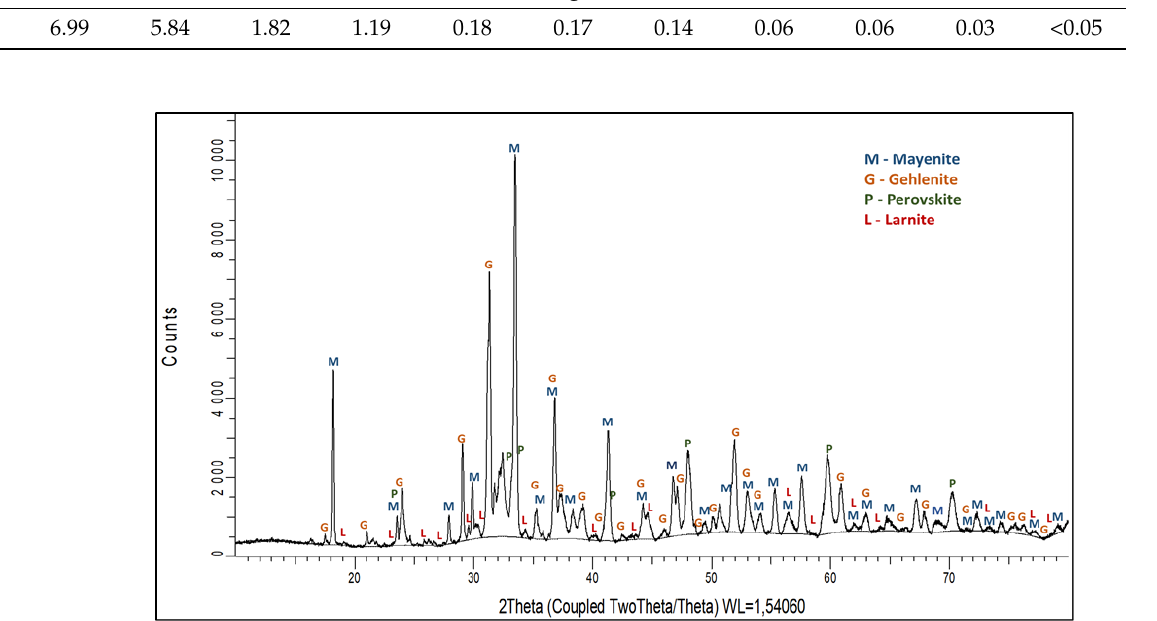
Figure 2 . XRD spectrum of slag with the identified phases. Figure 2. XRD spectrum of slag with the identified